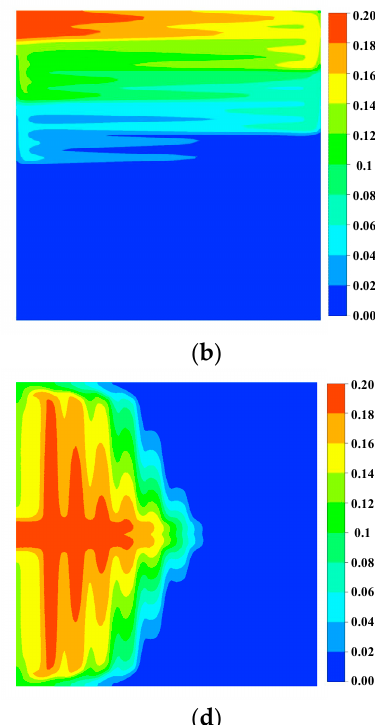
Figure 6. Oxygen mass fraction of cathode gas diffusion layer (0.8 V): ( a ) Snowflake bionic flow channel; ( b ) dual serpentine flow channel; ( c ) leaf-shape bionic flow channel; ( d ) lung-shape bionic flow channel.